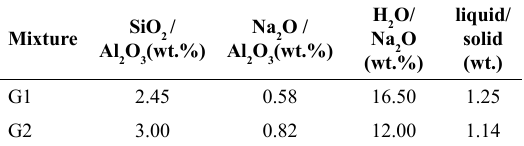
Table 7. Crystalline-amorphous quantification of G1 and G2